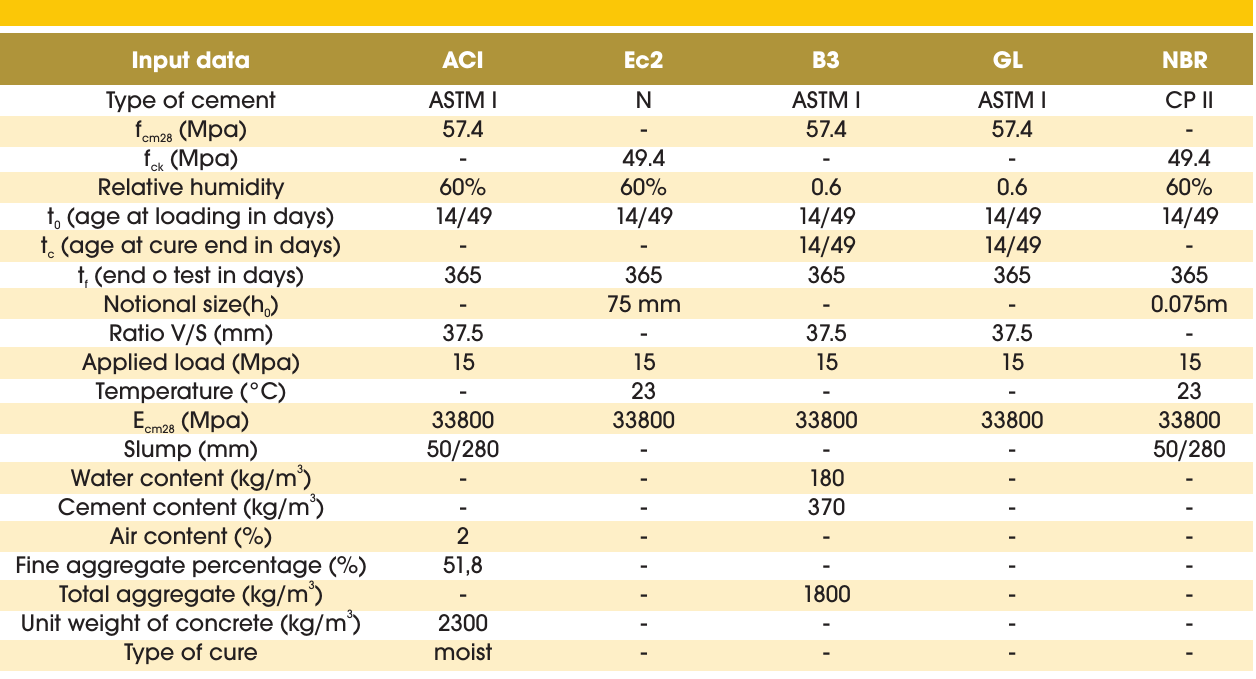
Table 6 – Prediction models input data